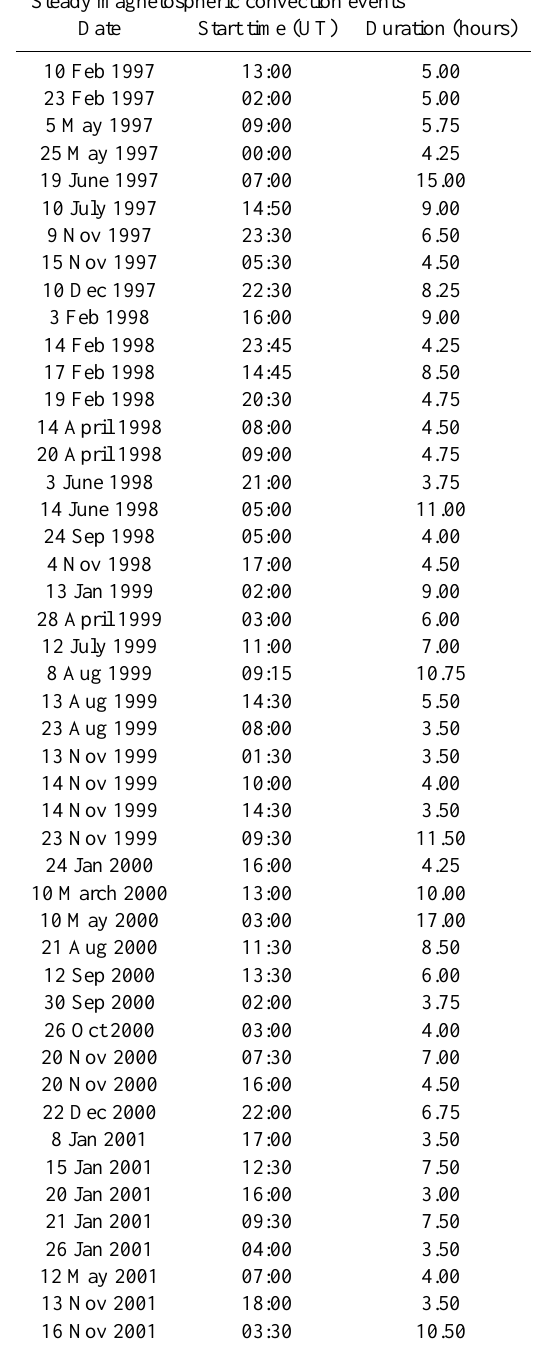
Table A1. A List of SMCs used in the statistical study. Events were determined using the methodology set forth in DeJong and Clauer (2005). Start times are approximate and err on the side of cation, in that reconnection rates are balanced by the start